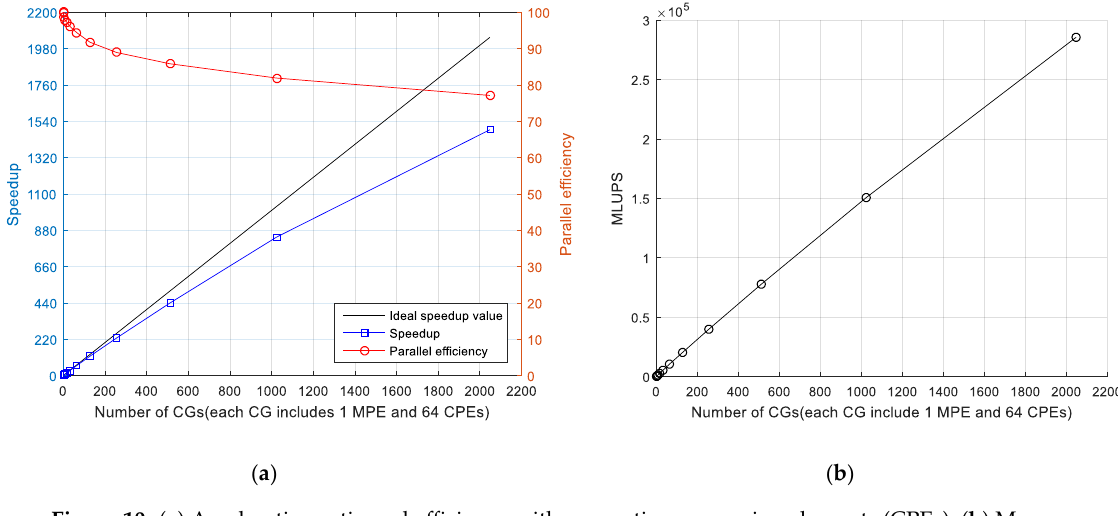
Figure 10. ( a ) Acceleration ratio and efficiency with computing processing elements (CPEs); ( b ) Mega Lattice Site Updates Per Second (MLUPS) with CPEs. Lattice Site Updates Per Second (MLUPS) with CPEs.